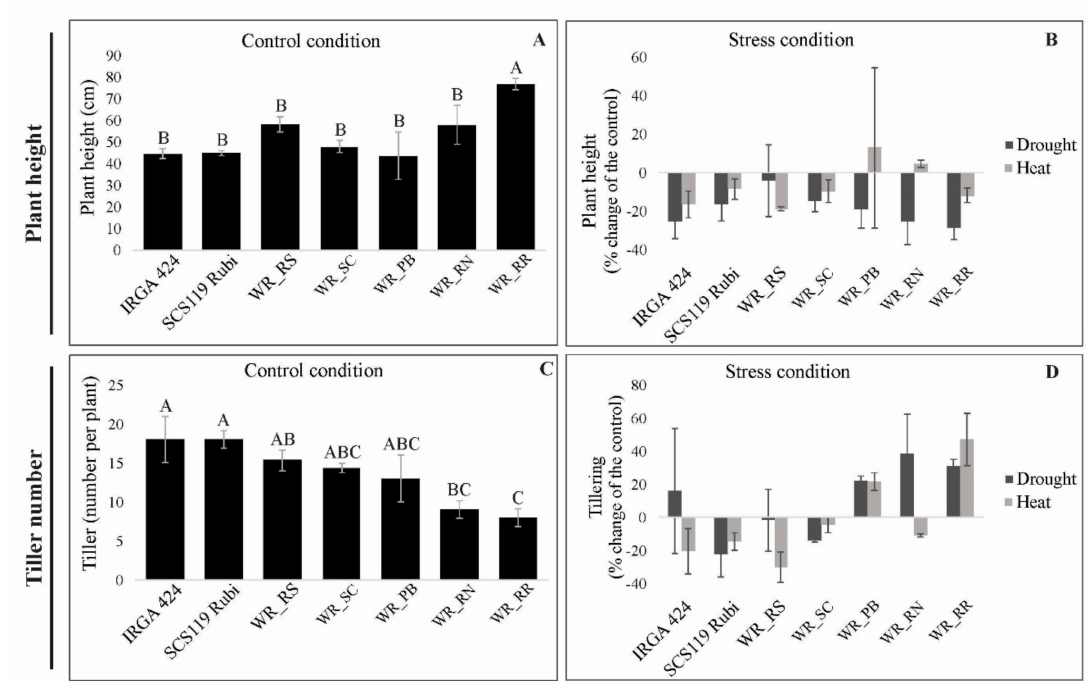
Figure 2. Morphological analysis of rice and weedy rice genotypes. Plant height in control ( A ) and in stress condition ( B ); tiller number in control ( C ) and in stress condition ( D ). Means followed by different uppercase letters are different based on Tukey’s test ( p < 0.05). Error bars represent 95% confidence